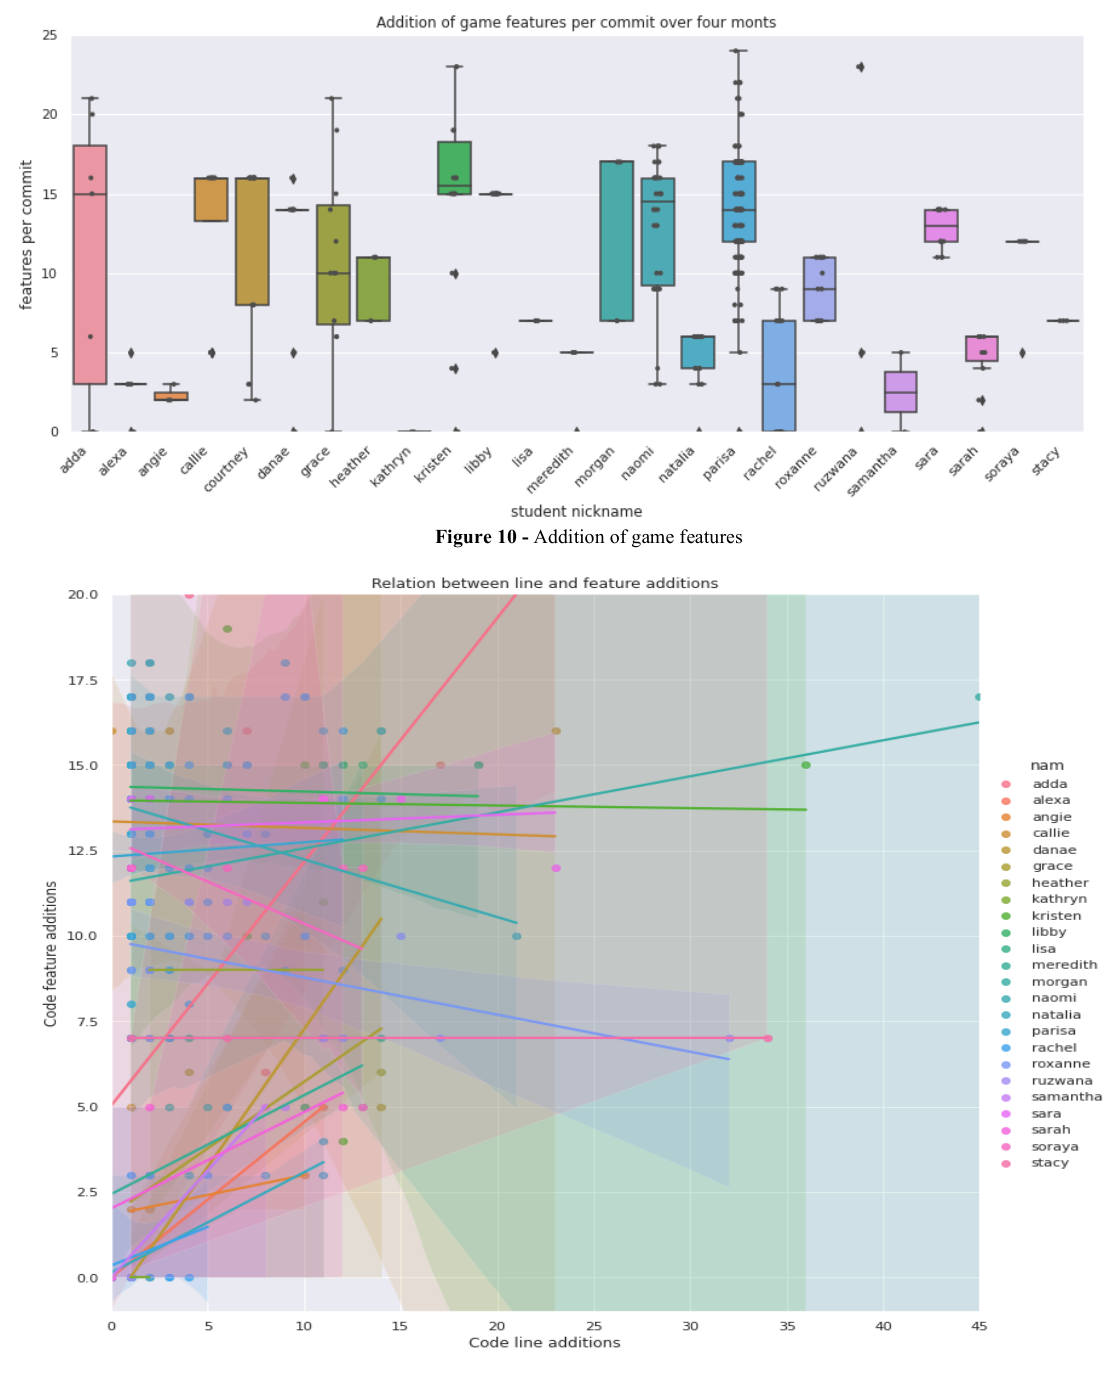
Figure 11 - Correlation between lines added and game